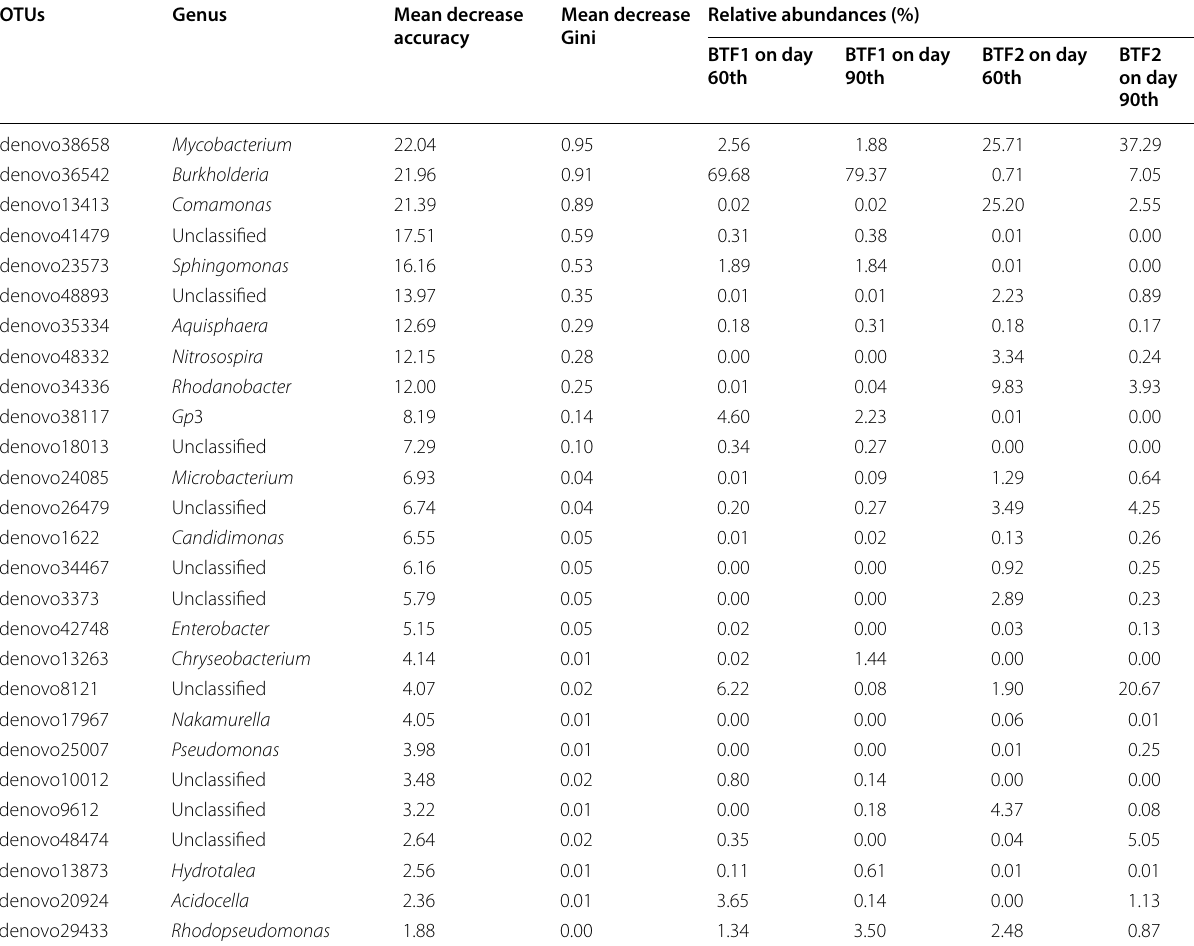
Table 3 OTUs with high importance score in the random forest model